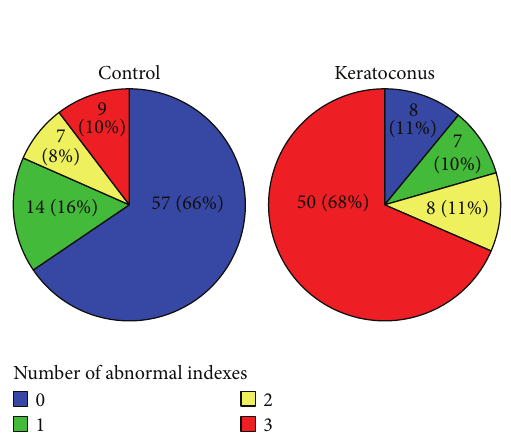
Figure 3: Group composition by number of abnormal biomechan- ical indices. Groups 1 (control) and 2 (subclinical keratoconus) rep- resented in pie charts by the number of abnormal biomechanical indices (ccCRF, BiomechScore, and